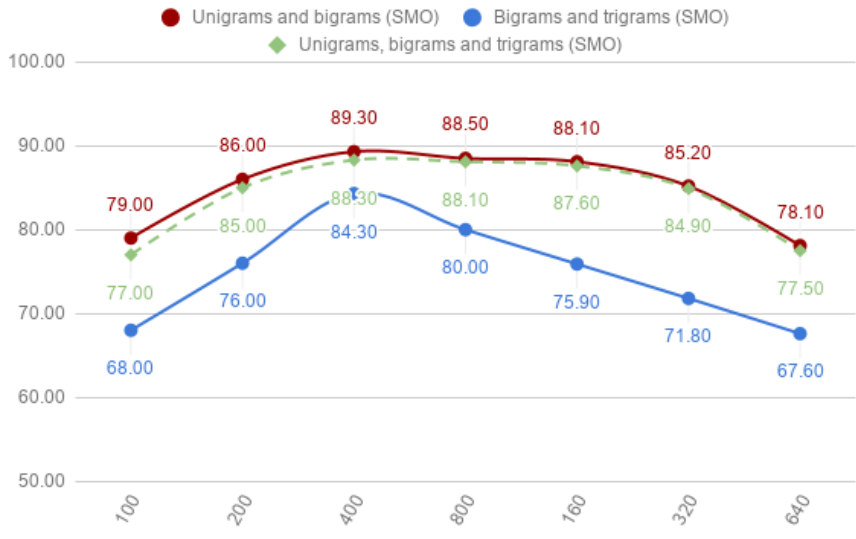
Figure 7. Combinations of unigrams and bigrams, bigrams and trigrams, and unigrams, bigrams and trigrams for the Sequential Minimal Optimization (SMO)